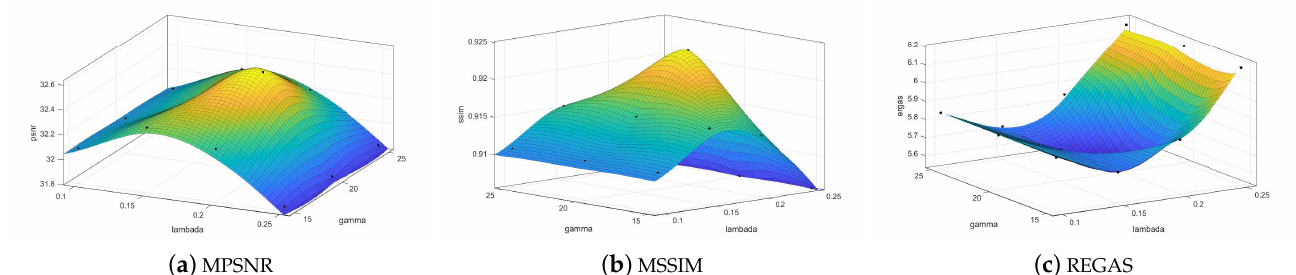
Figure 13. In case 4 of the simulated WDC dataset, the sensitivity analysis of the parameters λ and γ is carried out by using the MPSNR, MSSIM, and ERGAS.